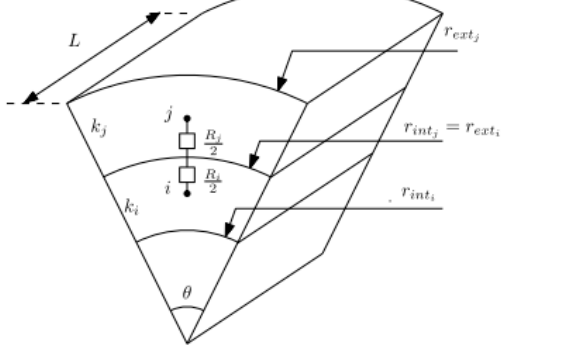
Figure 5. Thermal model.